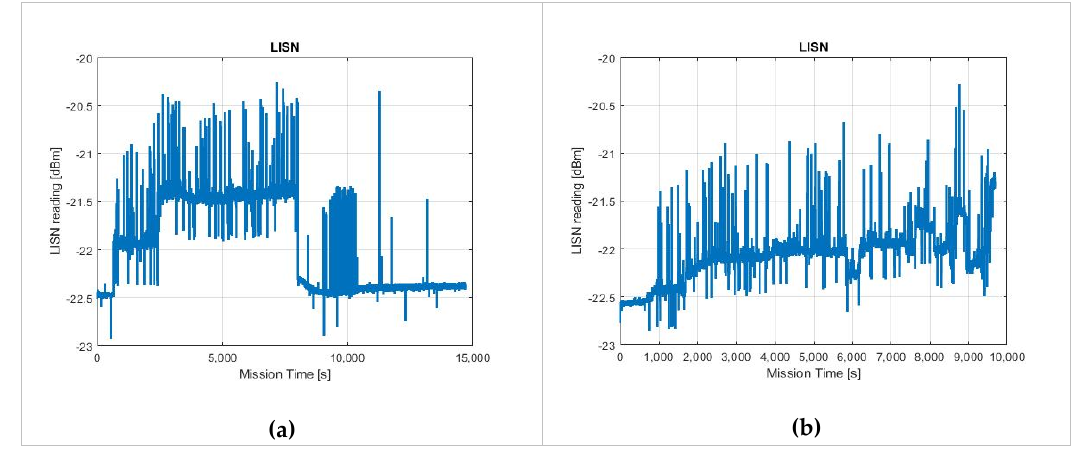
Figure 15. LISN circuits outputs ( a ) in laboratory conditions, ( b ) in vacuum.